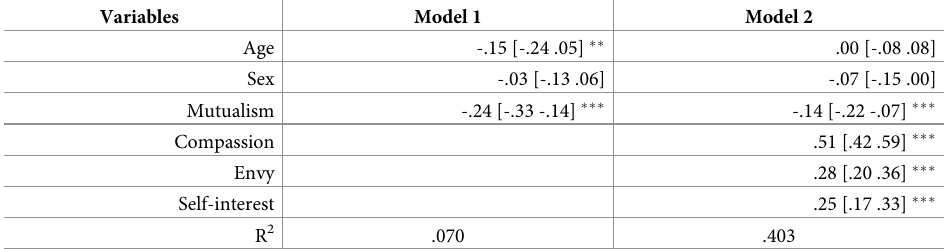
Table 2. Regression models predicting support for redistribution.